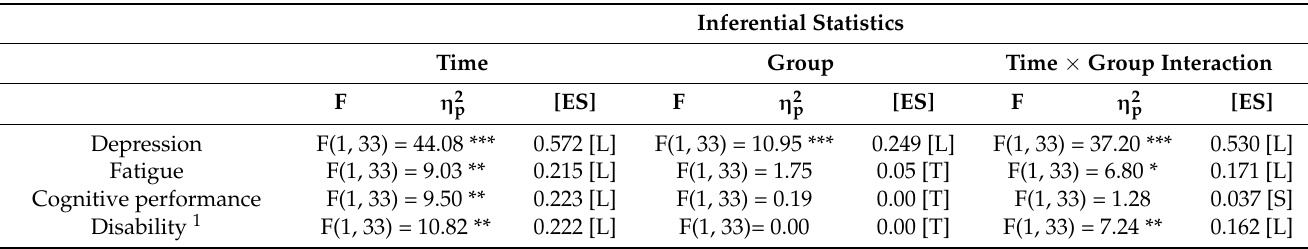
Table 3. Inferential statistical indices of the key outcome variables with the factors Time (baseline vs. study end), Group (rTMS vs. sham), and the Time ×